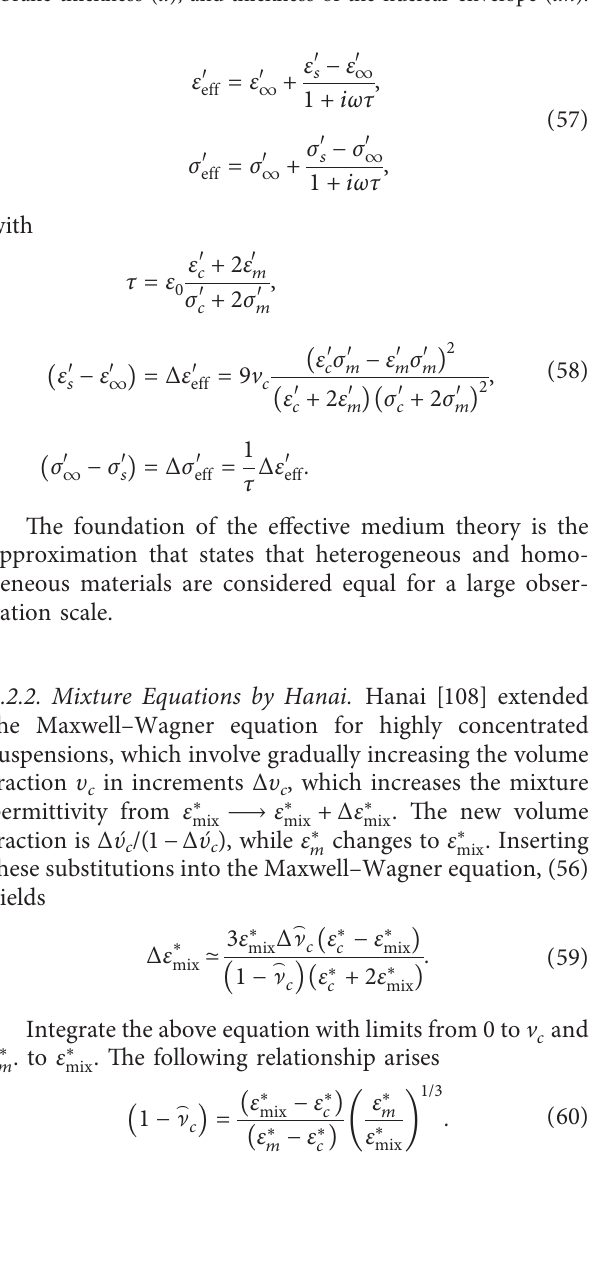
Figure 5: Illustration of (a) the one shell model and (b) dual shell model. All the subscripts for the complex permittivity designate the plasma membrane ( m ), inner phase of the cell ( i ), cytoplasm (cyt), nuclear envelope ( ne ), and nucleoplasm ( np ). The other parameters are as follows: the outer cell radius ( R ), outer radius of the nucleus ( R n ), plasma membrane thickness ( d ), and thickness of the nuclear envelope ( dn